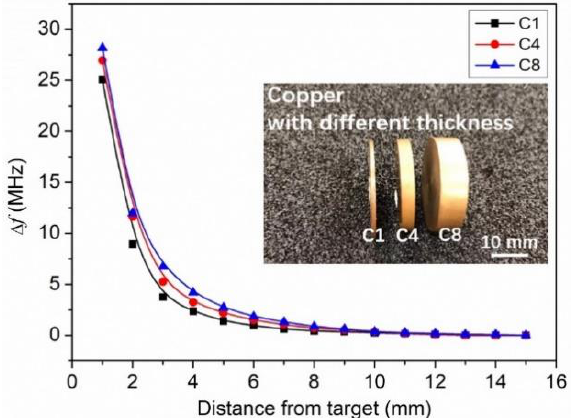
Figure 8. Frequency shift of the LC proximity sensor in dependence of distance from the targets of C1, C4, and C8.